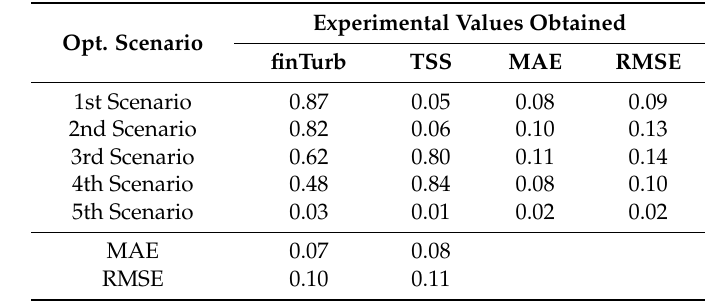
Table 20. Experimental outputs that were obtained according to the five clarification optimization scenarios for ECOTAN BIO 100.